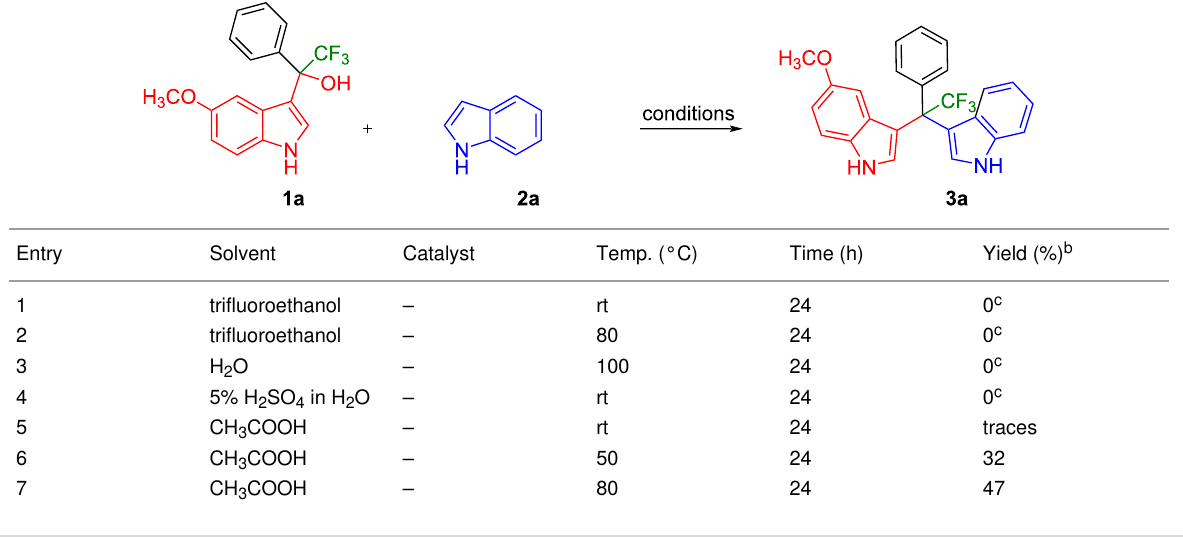
Table 1: Optimization of the reaction conditions for the preparation of 5-methoxy-3-(2,2,2-trifluoro-1-(1 H -indol-3-yl)-1-phenylethyl)-1 H -indole ( 3a ) a .